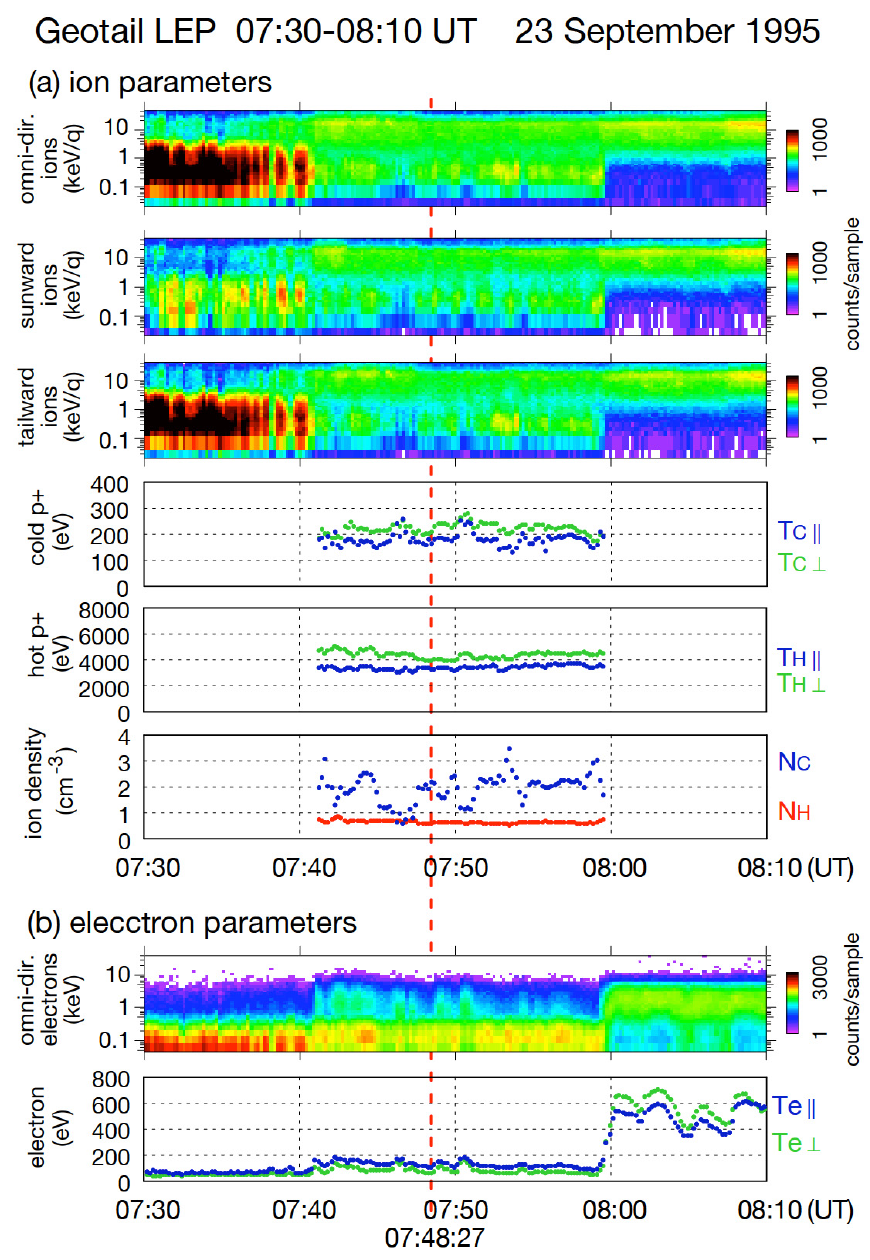
Fig. 6. Geotail observations between 07:30–08:10 UT on 23 September 1995 in the same format as Fig.